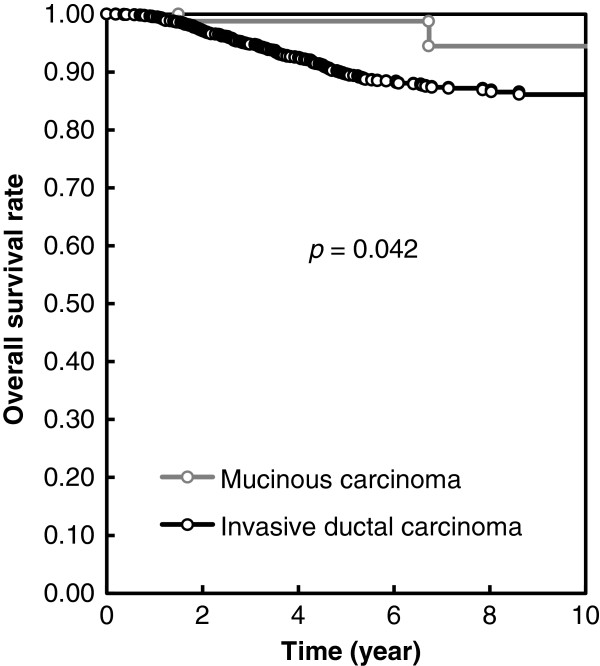
Overall survival curve of patients.